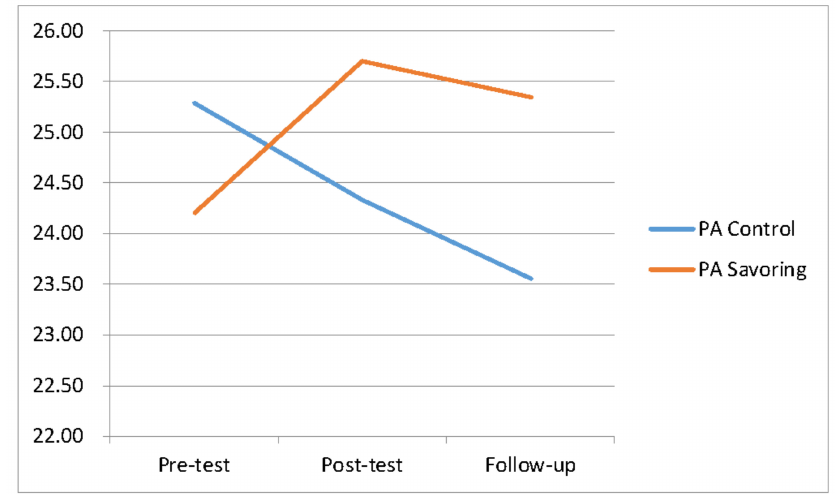
Figure 2. Changes in original mean score of PA during di ff erent stages. Table 1. Summary of Means and Standard Deviations for scores on positive a ff ect (PA), negative a ff ect (NA), and Center for Epidemiologic Studies Depression Scale (CES-D). Pre-Test Post-Test Follow-Up Measure Condition M (SD) M (SD) M (SD) PA Exp 24.20 (6.07) 25.71 (5.44) 25.35 (4.59) Con 25.30 (6.30) 24.33 (5.84) 23.55 (6.28) NA Exp 15.45 (4.73) 15.94 (4.92)